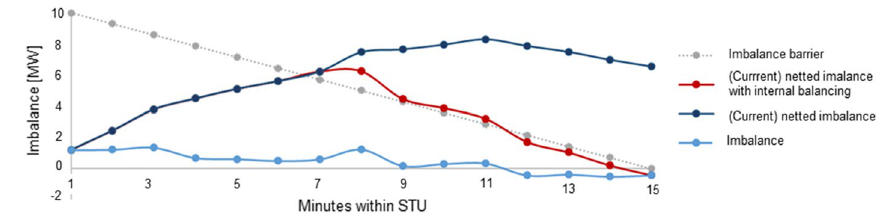
Fig. 4 Illustrative example of the application of the decision model on real-data world imbalance